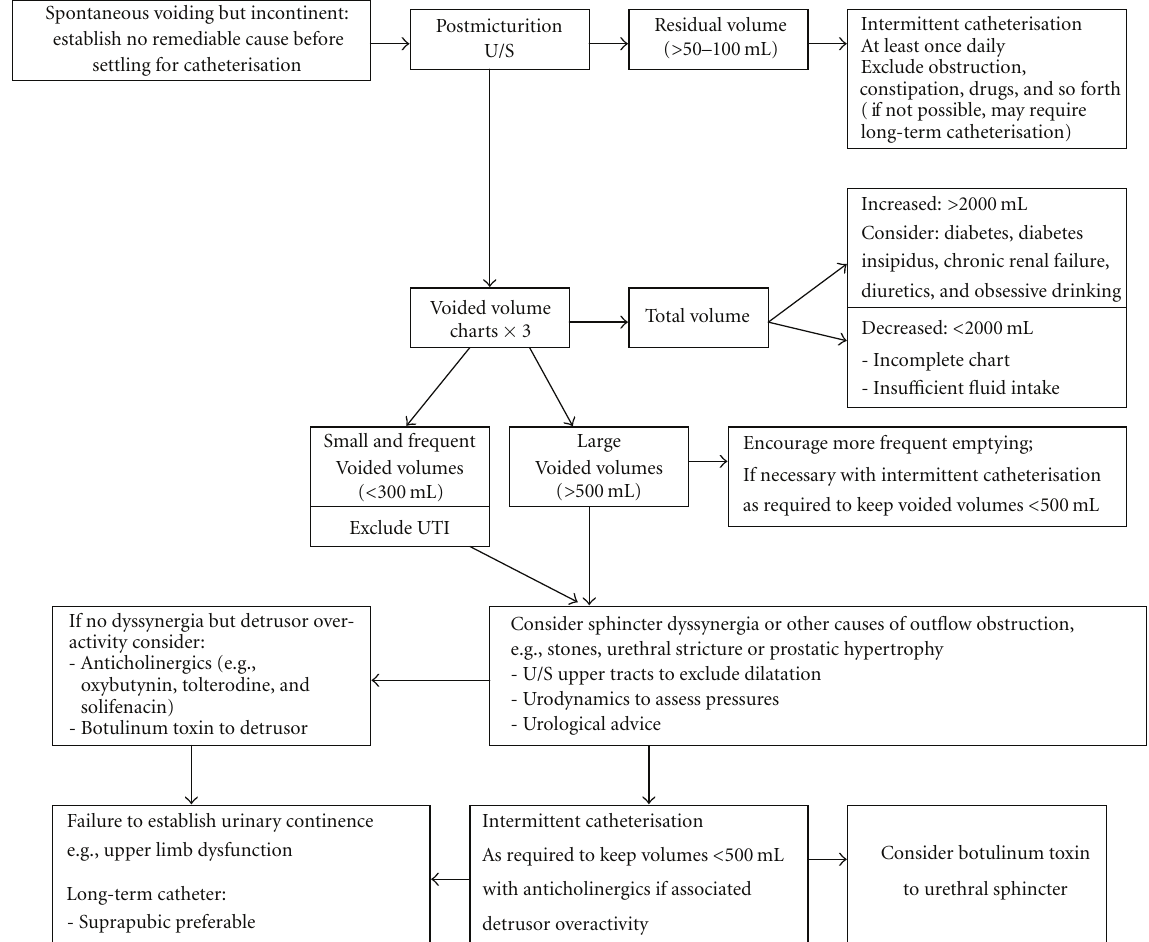
Figure 4: Managing urinary incontinence in patients with long term neurological conditions including primary progressive MS. (Printed with permission: RCP 2008